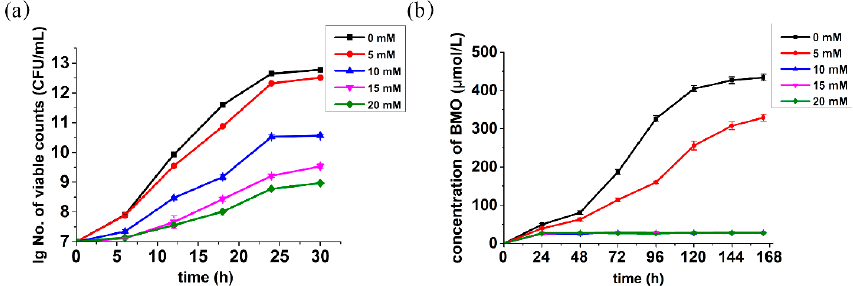
Figure 3. Effects of β‐ keto ester on the bacteria growth ( a ) measured by spread plate method and ( b ) ( b ) the manganese mineralization; various colors refer to di ff erent concentrations of 1 ; CFU: colony the manganese mineralization; various colors refer to different concentrations of 1 ; CFU: colony forming forming units.